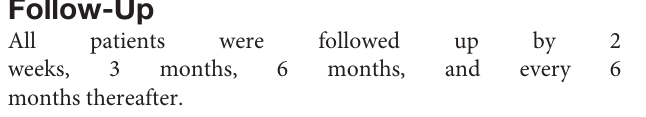
Frontiers in Cardiovascular Medicine |